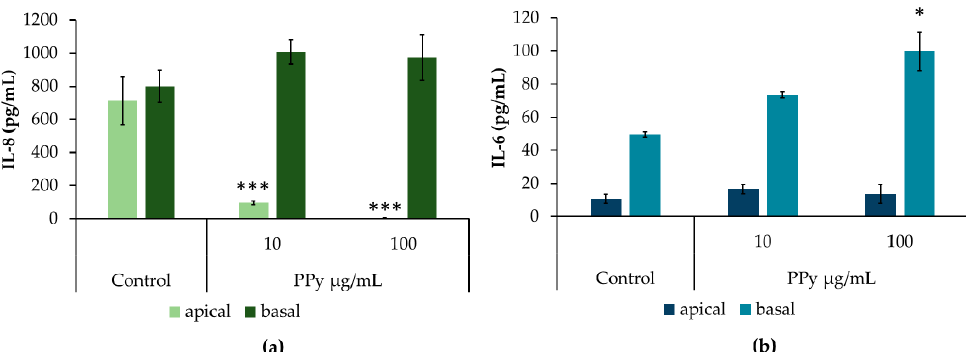
Figure 6. Cytokine release. IL-8 ( a ) and IL-6 ( b ) release from both upper (apical) and lower (basal) compartments of the inserts apically exposed for 24 h to PPy (10 and 100 µg/mL). Data were expressed in pg/mL and represented as mean ± SE of three independent experiments ( n = 3). * p < 0.05; *** p < 0.001. Significantly different from the respective control.